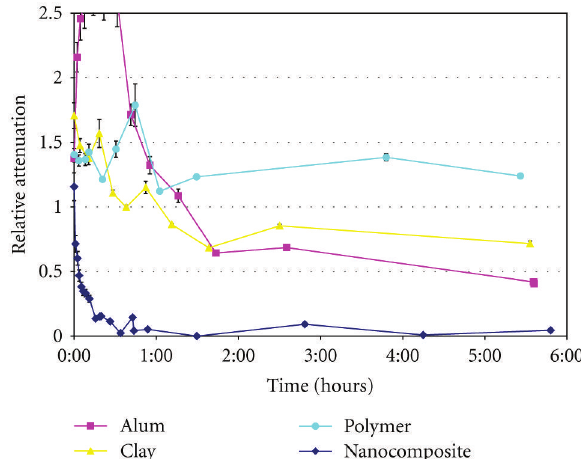
Figure 4: Relative light attenuation of winery e ffl uents as a function of time, upon addition of 0.1% alum, 0.1% poly-DADMAC/se- piolite nanocomposite, and the equivalent amounts of sepiolite (clay) or poly-DADMAC (polymer)